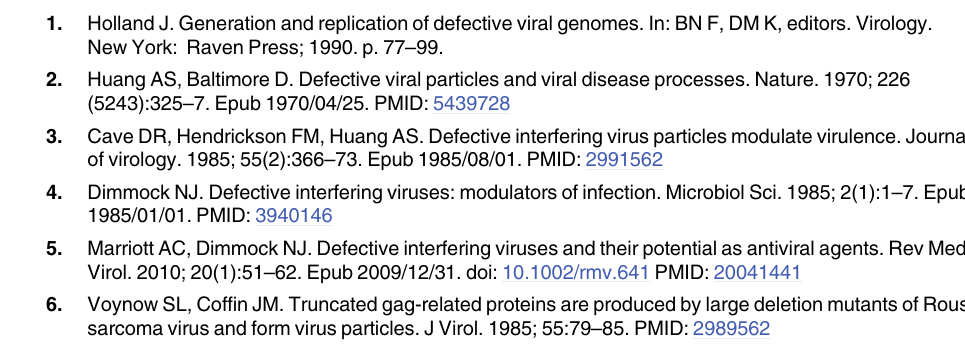
S8 Fig. TIP dynamic and evolutionary stability do not hinge on the suppression of HIV viral loads or transmission. (A) TIP stability when HIV viral loads and transmission are assumed to suppressed by TIPs. (Left panel) HIV+TIP- prevalence, (middle panel) HIV+TIP + prevalence, and (right panel) invasion analysis of HIV mutants performed as in Fig 3C. (B) TIP stability when HIV viral loads and transmission are assumed to be unsuppressed by TIPs. (Left panel) HIV+TIP- prevalence, (middle panel) HIV+TIP+ prevalence, and (right panel) invasion analysis of HIV mutants performed as in Fig 3C. Both the prevalence of HIV+, TIP- hosts and the evolutionary stability of TIPs remain virtually unchanged despite the absence of HIV suppression, because the additional transmission of HIV is matched by the increased spread of the TIP. S9 Fig. Transmission rates, rather than death rates, are the key determinants of HIV trans- mission potential. (A) Transmission potential assuming constant host death rates. (B) Trans- mission potential with changing death